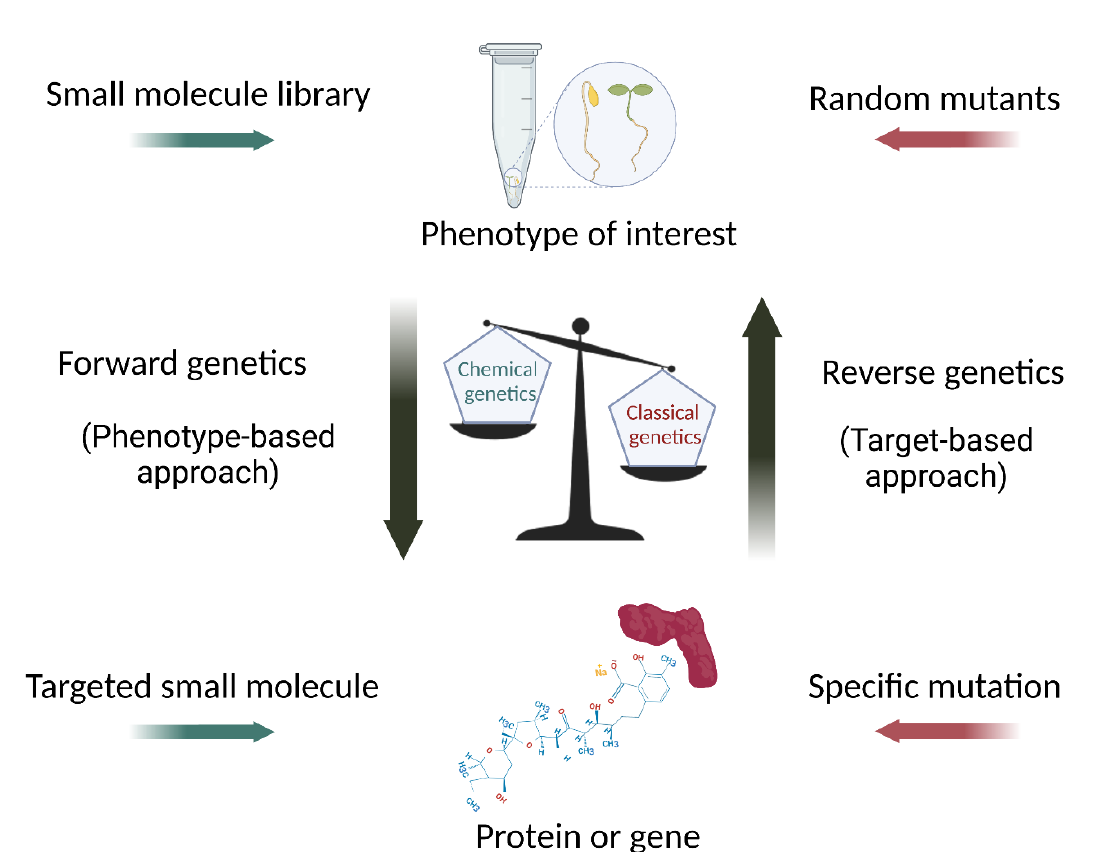
Figure 1. Comparison between the chemical and the classical genetic strategies. For both forward